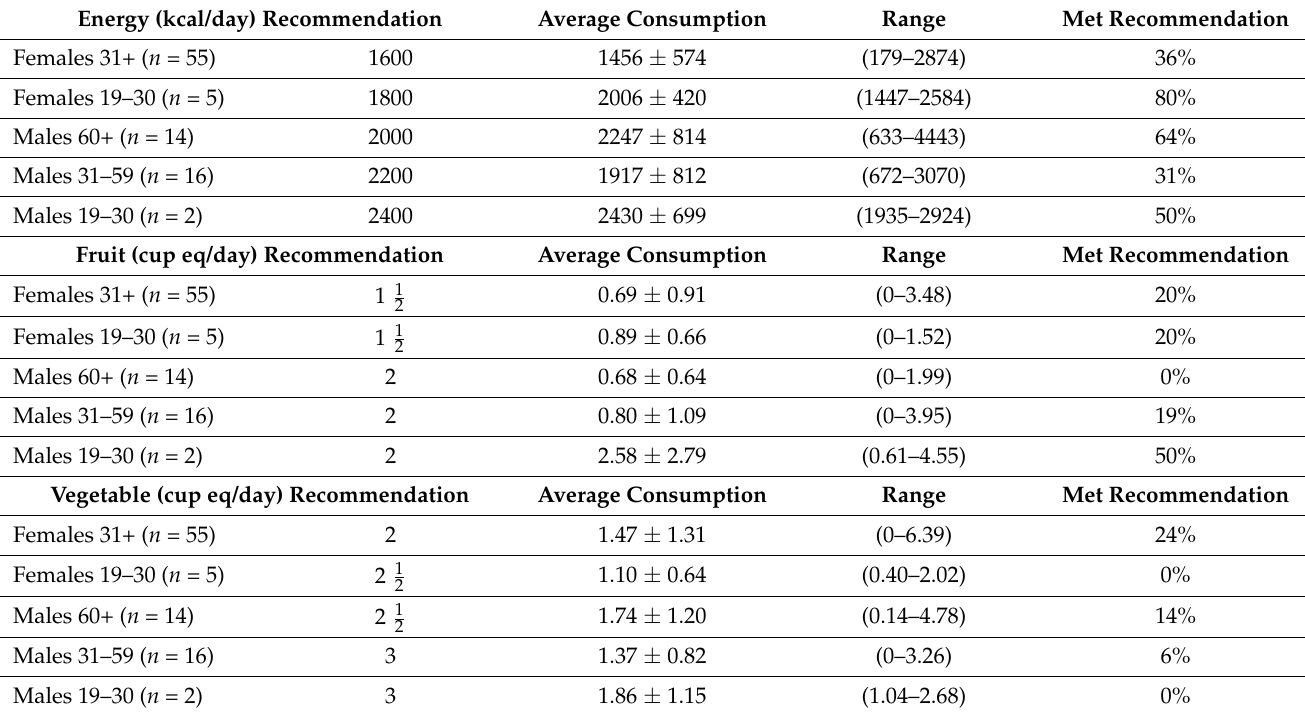
Table 3. Average intake of energy, fruit, and vegetables.